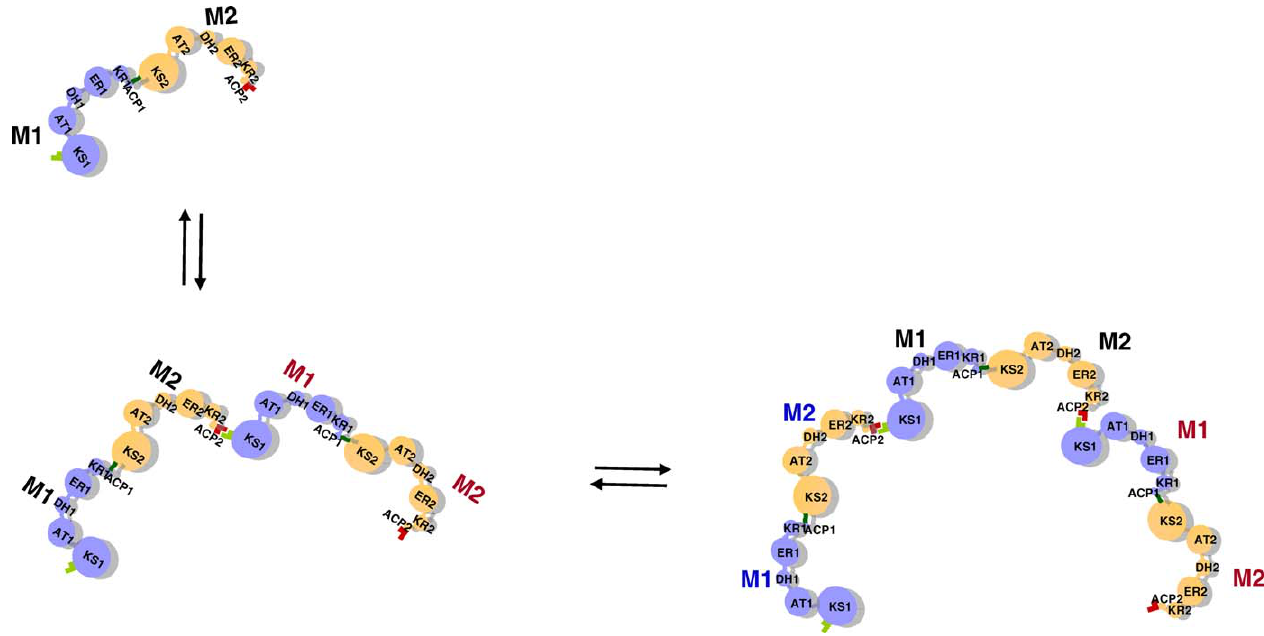
Figure 10. Schematic Representation of Modularly Iterative Catalysis Supramolecular organization of PKS12 protein formed by interactions between N- and Cters.